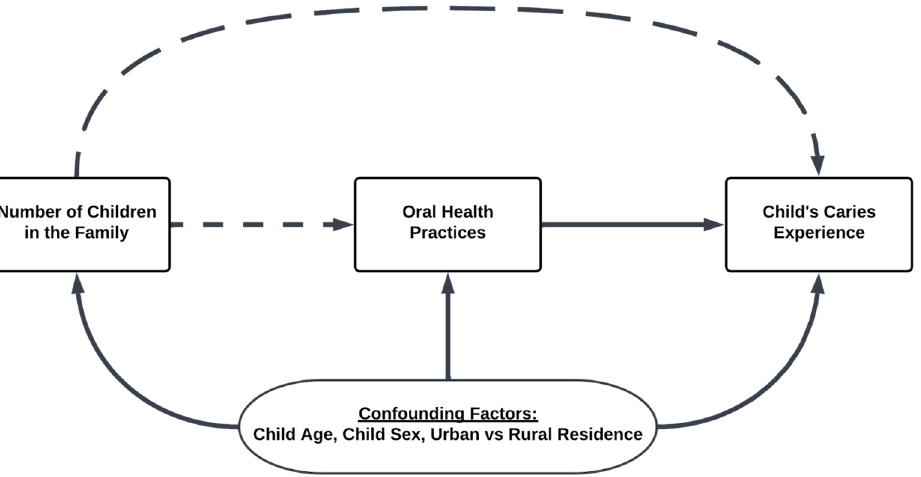
Figure 1. Hypothesized association between the number of children in the family, maternal-child oral health practices and child oral health outcomes. Dotted: our pathways of interest. Descriptive analysis, logistic regression, and Zero-Inflated Poisson (ZIP) regression models were performed through RStudio version 4.0.3 (PBC, Boston, MA, USA) [42]. G*power version 3.1.9.6 (Heinrich Heine University Düsseldorf, Düsseldorf, Germany)